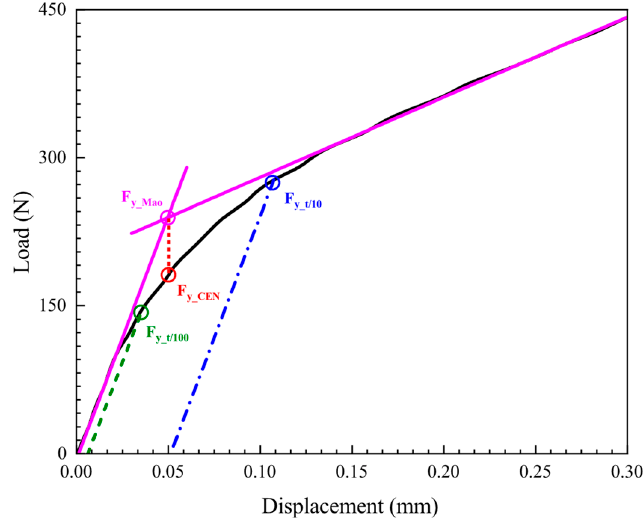
Figure 12. Different methods of determining the force F y on SPT curve.